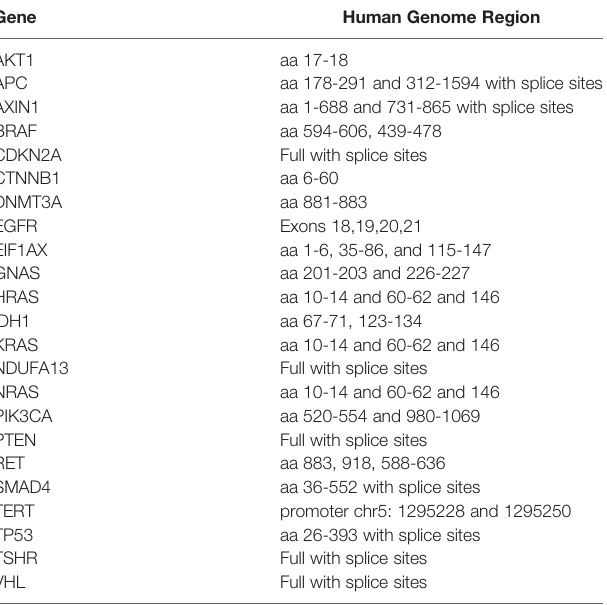
TABLE 1 | High risk genes on NGS used as a reference standard.